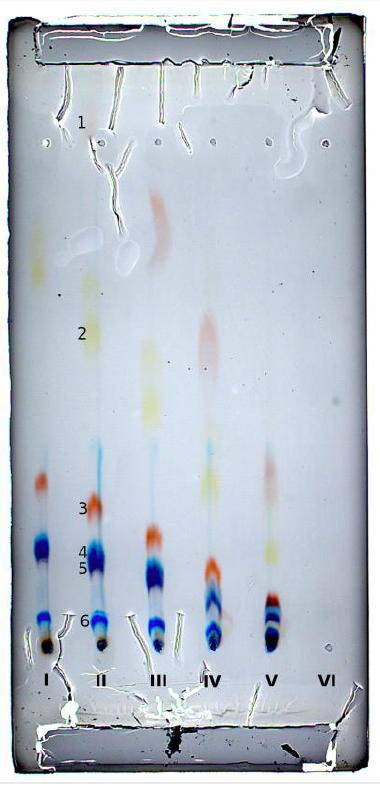
Figure 4. Chromatogram OPLC with online sample application and offline detection: 1 µL of the mixture was injected to the five separation channels, with 3 min delay between sample application in each subsequent channel. Separation system used: HPTLC RP-18 W chromatographic plates; water/methanol (3/2 v/v ) with addition of 80 mM ammonium formate pH 3.0 as the mobile phase; total mobile phase flow 0.25 mL/min; voltage 0 kV; temperature 25 °C, cushion pressure 100 bar; and mobile phase backpressure 96 bar. Dye mixture: 1 — ponceau red; 2 — sunset yellow; 3 — allura red; 4 — brilliant blue; 5 — azorubine; and 6 — patent blue; concentration of each dye was 0.07% w/v .